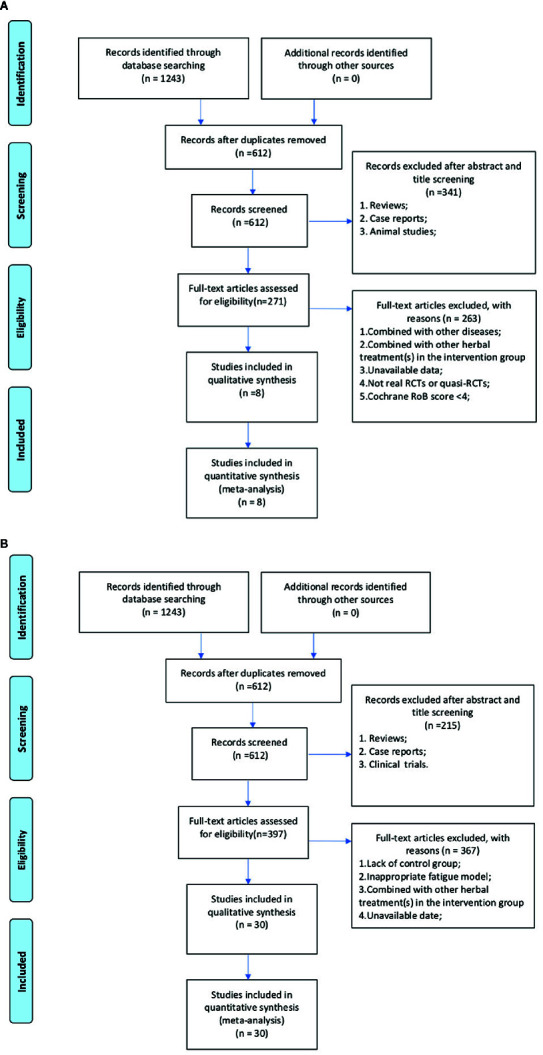

(A) Flow diagram of randomized control trials selection process. (B) Flow diagram of animal experiments selection process.